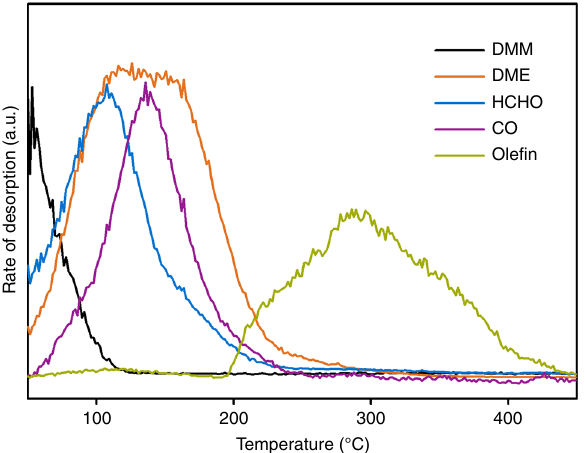
Fig. 4 Surface reaction of DMM adsorbed on H-ZSM-5 with increasing temperature. Reaction conditions: H-ZSM-5 (Si/Al 15) 25 mg saturated